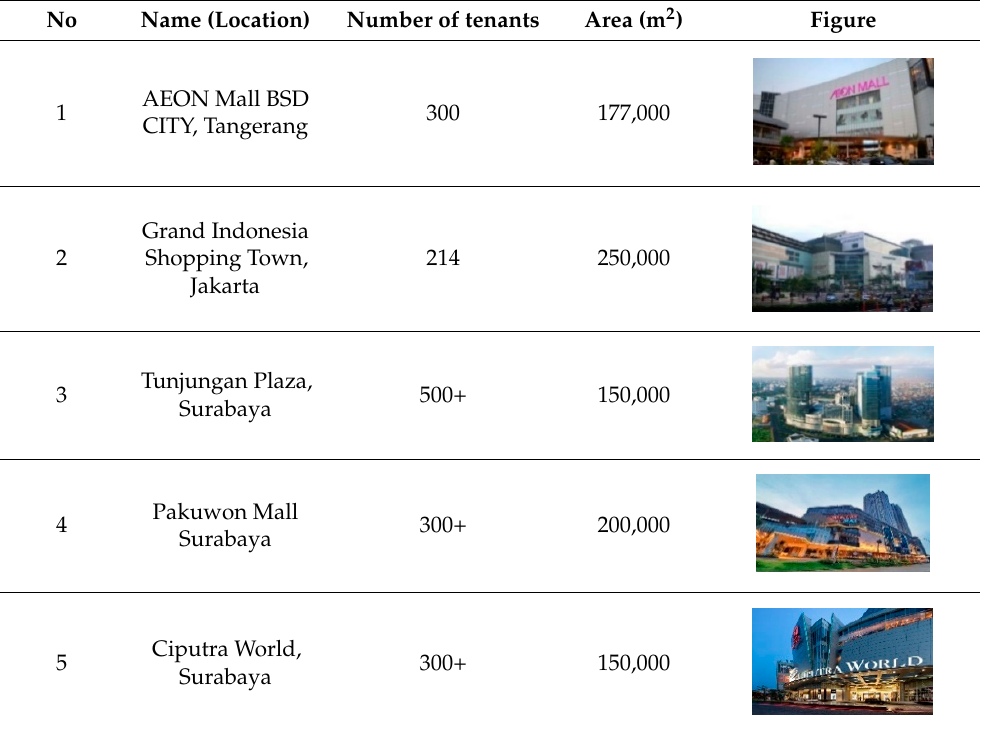
Figure 1 . Supply and demand retail property development in Indonesia. Table 1. Several shopping centers in Indonesia 2021.